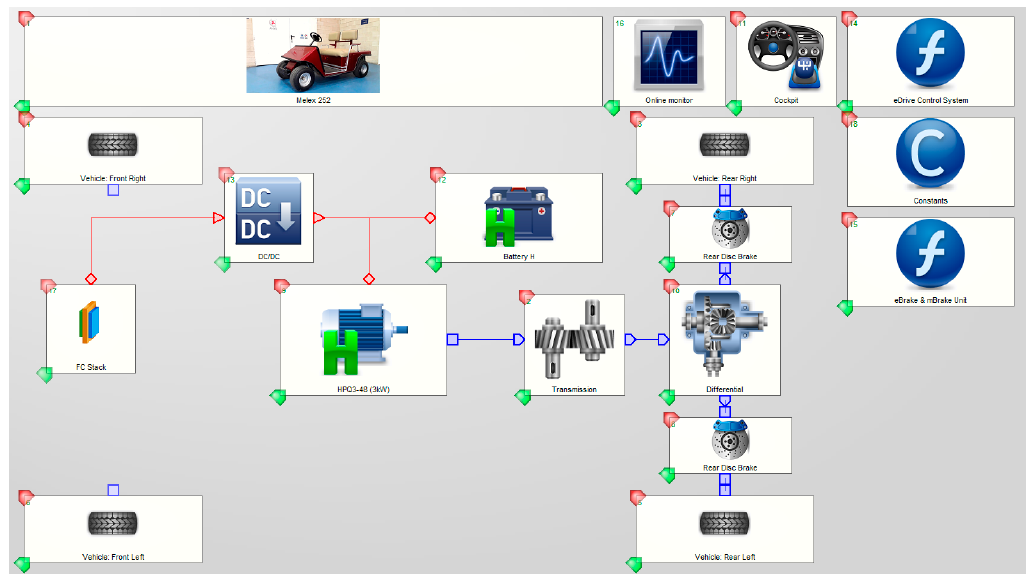
Figure 11. Simulation of Fuel Cell Extended Range Electric Vehicle Model.